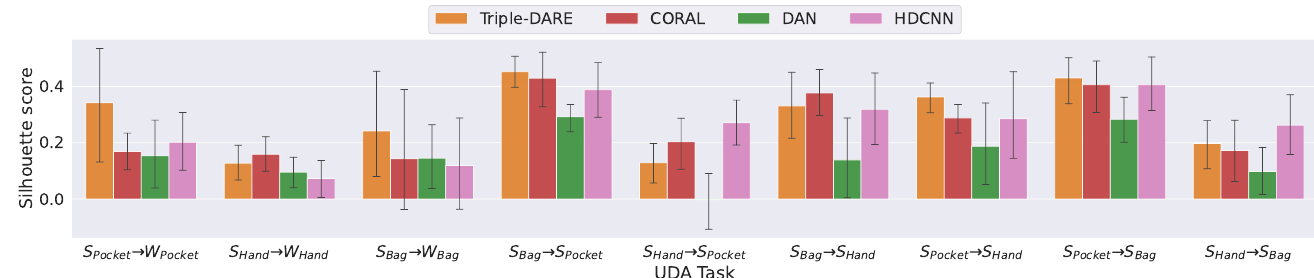
Figure 9. Compactness measure on feature embeddings.